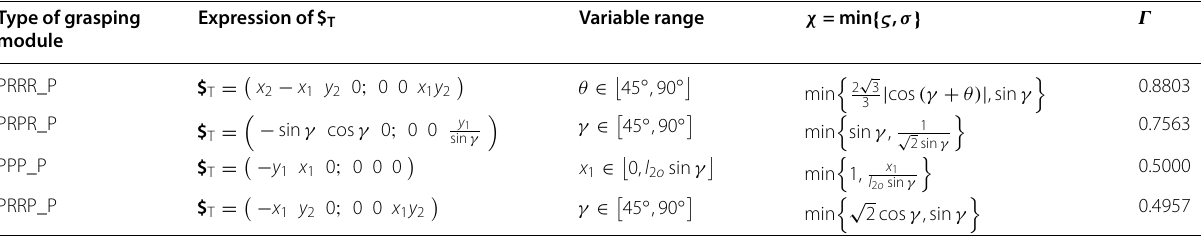
Table 4 Motion/force transmission performance of the closed-loop structure of the grasping module Type of grasping Expression of $ T Variable range χ = min { ς , σ module